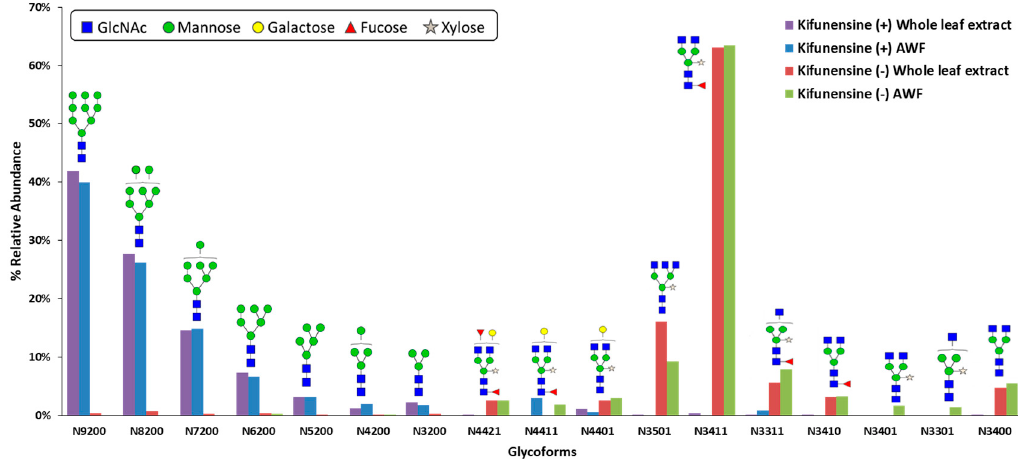
Figure 2. N -Glycan structures analysis of CMG2-Fc with/without Kifunensine treatment from whole-leaf extract and AWF samples. The relative abundance of glycoforms is represented in this bar chart. The annotations on x -axis represent numbers of N -linked glycan molecules: mannose and galactose/GlcNAc/Fucose/Xylose residues, respectively. Red and green bars: without kifunensine, resulted in addition of complex-type N -glycans. Purple and blue bars: vacuum infiltrated with kifunensine at 5.4 µM, resulted in predominantly oligomannose-type N -glycans, Man 3–9 GlcNAc 2 .